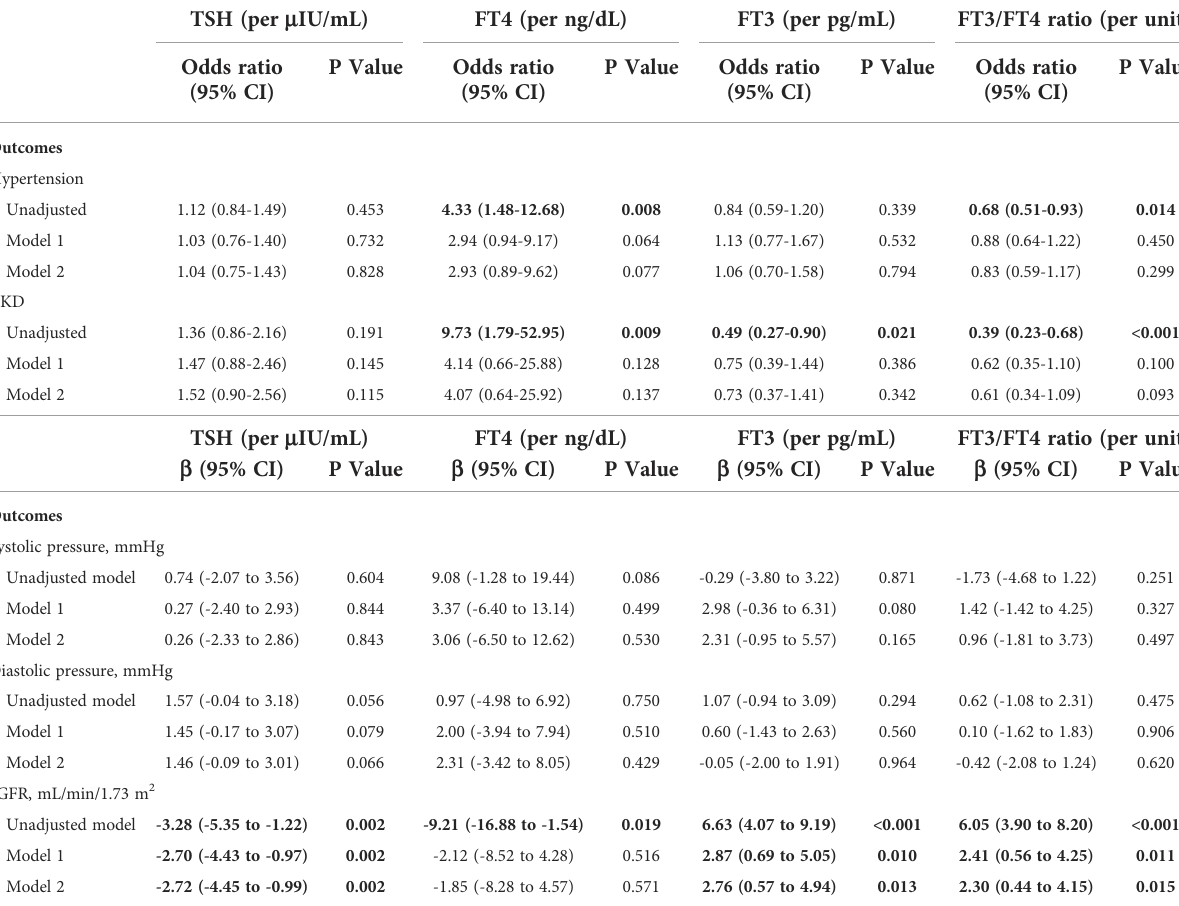
TABLE 5 Association of thyroid function with hypertension, systolic and diastolic blood pressure, kidney function, and chronic kidney disease.